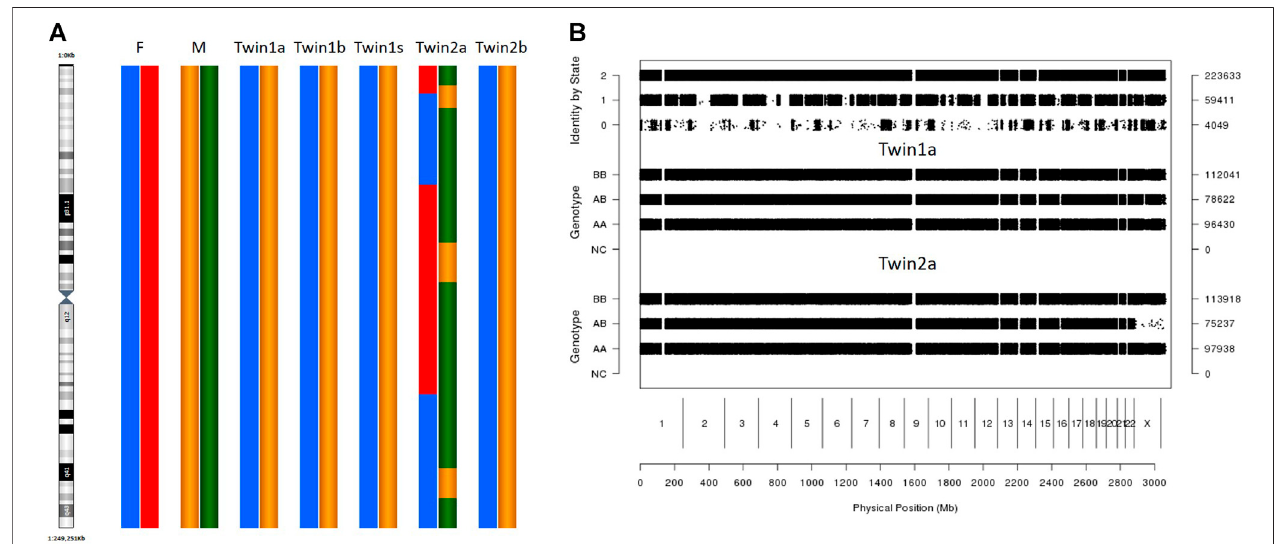
FIGURE 1 | SNP array result of different tissues. (A) Karyomapping (chr1) of different tissues in twins. F: father M: mother. Twin1a/b/s: Oral mucosa cells, blood, and spermintwin1.Twin2a/b:Oralmucosacells,blood intwin2. (B) ResultofpairwiseSNP analysisingenomewide.SNPanalysisusedtheSNPduoWebtool.Identity by state (IBS) 2: both alleles shared between twins; IBS1: single allele shared between twins; IBS0: non-allele shared. Twin1a: Oral mucosa cells twin1. Twin2 a: Oral mucosa cells in twin2.